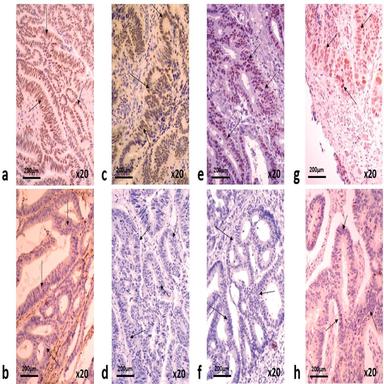
Typical immunohistochemical images of MMR protein nuclear expression: (a,b) Extensive expression and loss of expression of MLH1 protein, respectively; (c, d) Extensive expression and loss of expression of PMS2 protein, respectively; (e,f) Extensive expression and loss of expression of MSH2 protein, respectively; (g,h) Extensive expression and loss of expression of MSH6 protein, respectively.